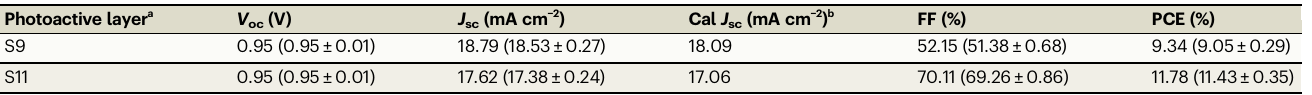
Data in parentheses areaveragevalueswith standard deviationfrom 15devices. a The device area: 4.5mm 2 . b Integrated current density obtainedfromEQE spectra.